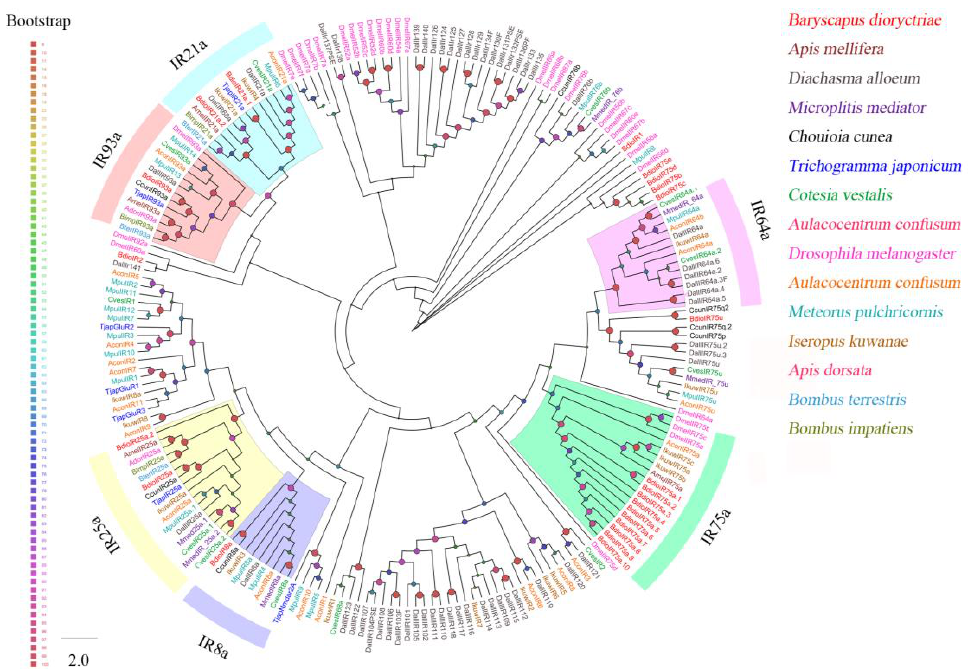
Figure 5. Phylogenetic tree of 211 ionotropic receptors (IRs) from B. dioryctriae and 13 other Hyme- noptera species. The protein sequences used in this phylogenetic analysis are listed in the Supple- mentary Materials (File S5). The size and color of the dots reflect their bootstrap values. The color scale is shown on the left, with larger dots indicating larger bootstrap values.